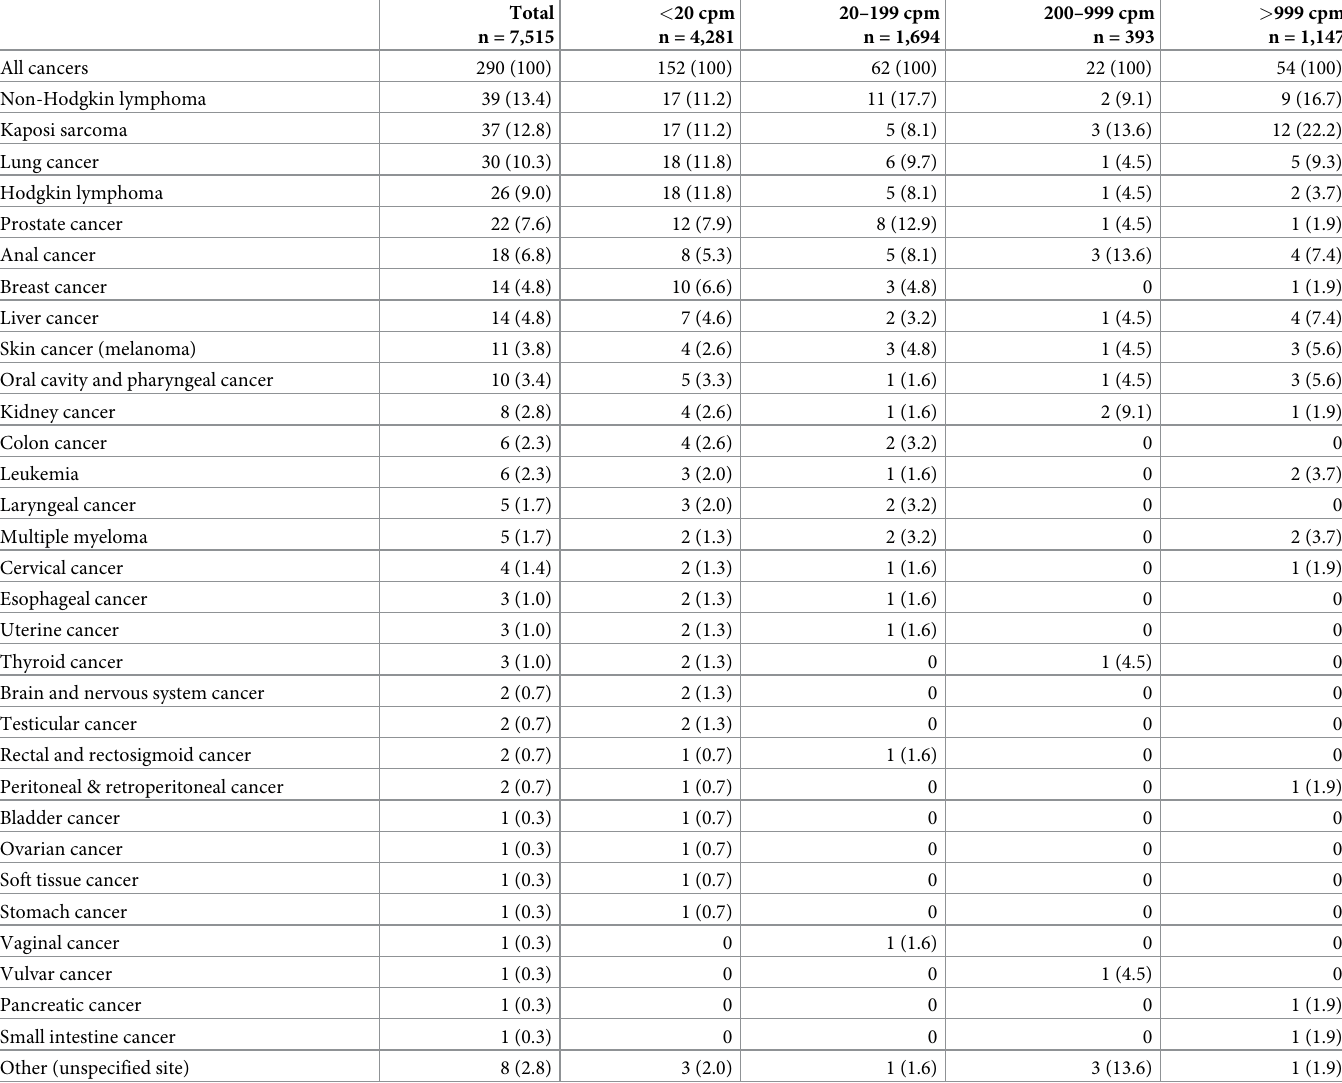
Table 2. Number (%) of cancers observed in 7,515 CNICS patients, averaged over 30 imputations (rounded to nearest integer).